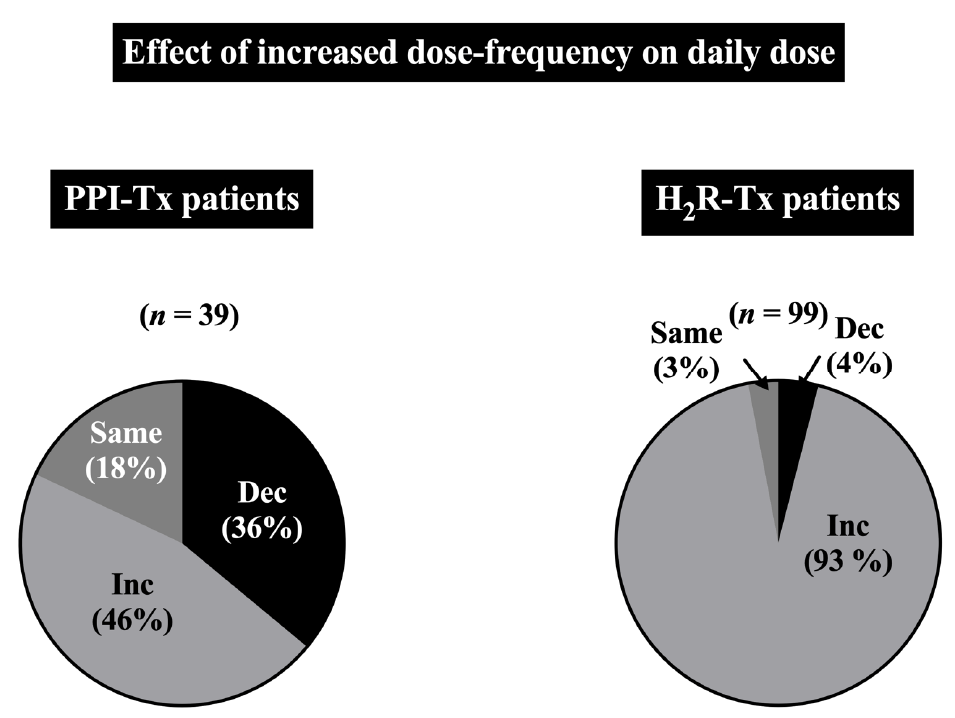
Figure 5. Distribution of the first and final total daily drug dosages in 303 ZES patients with long-term treatment with either a histamine H 2 -receptor antagonist or proton pump inhibitor. In the top panel, the distribution of the first and final total daily drug doses are separated for patients taking PPIs once, twice, or three times per day. In the bottom panel, the first and last total daily doses of H 2 Rs are reported. Distributions at different drug doses are reported as the percentage of the total number of patients taking the given drug class at the listed total daily dosage. In the top panel, the drug dosages are reported as omeprazole-equivalent doses for the different PPIs, determined as described in the Section 2. In the bottom panel, the total daily H 2 R doses are reported as ranitidine-equivalent daily doses, determined as described in the Section 2 and previously in ref. [109,112,178]. The mean times between doses for both classes of drugs are shown above in the legend of Figure 2.